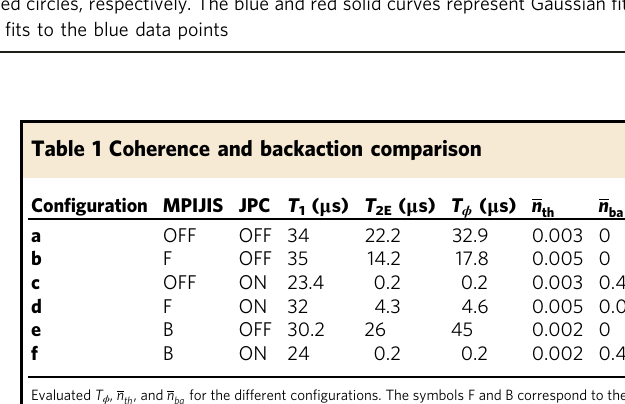
Fig. 4 Qubit measurement with the MPIJIS. Panels a – f outline the six possible con fi gurations of the qubit measurement setup shown in Fig. 3. In a , the MPIJIS and JPC are OFF. In b , the MPIJIS is ON and biased in the forward direction while the JPC is OFF. In c , the MPIJIS is OFF while the JPC is ON. In d , the MPIJIS and JPC are ON and the MPIJIS is biased in the forward direction. In e , the MPIJIS is ON and biased in the backward direction while the JPC is OFF. In f , the MPIJIS and JPC are ON and the MPIJIS is biased in the backward direction. The measurement results exhibited in the four columns for each con fi guration correspond to the net gain of the re fl ected readout signal relative to the HEMT-only case ( fi rst column from the left), the qubit readout fi delity measurement (second column), T 1 (third column) and T 2E of the qubit (fourth column). The measured histograms, in the second column, for the initialized ground (| g 〉 ) and excited (| e 〉 ) states are depicted using blue and red circles, respectively. The blue and red solid curves represent Gaussian fi ts. The red solid curves in the third and fourth columns represent exponential fi ts to the blue data points